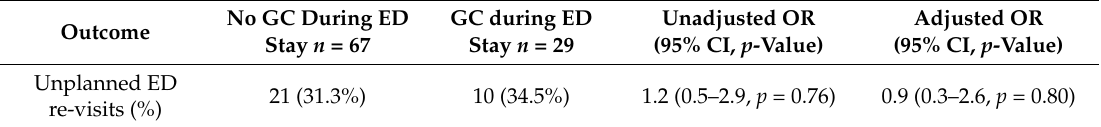
GC = Geriatric Consultation; OR = Odds Ratio; CI = Confidence Interval; ED = Emergency Department; All results were adjusted for a sex, Charlson co-morbidity index (<4/ ≥ 4), emergency severity index and positive